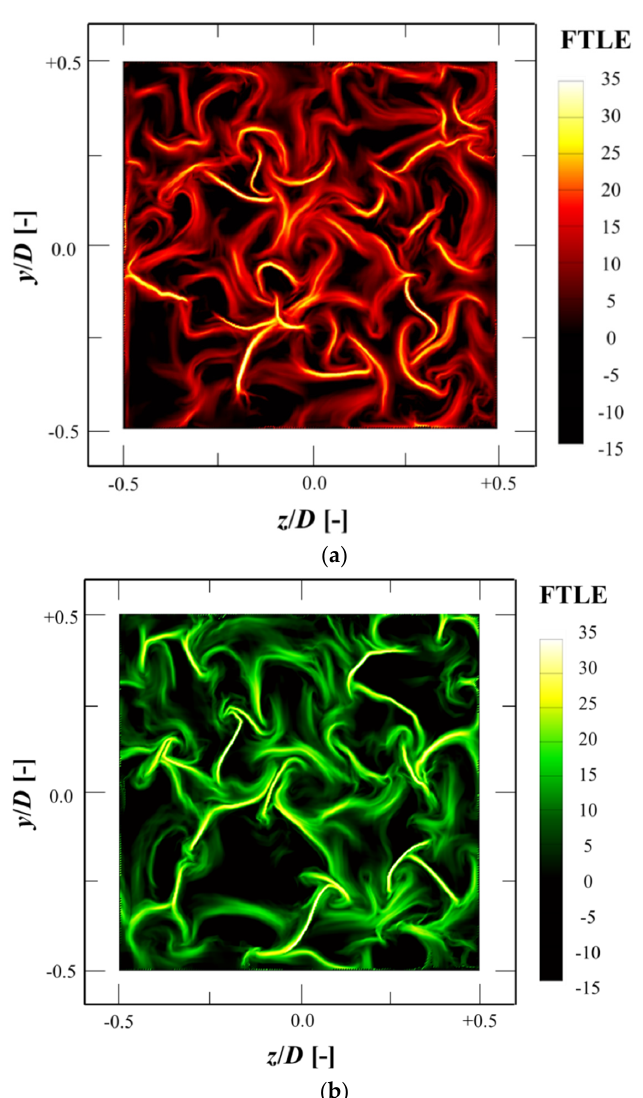
Figure 13. Contours of ( a ) forward and ( b ) backward finite-time Lyapunov exponent (FTLE) at x = 2.25 D.